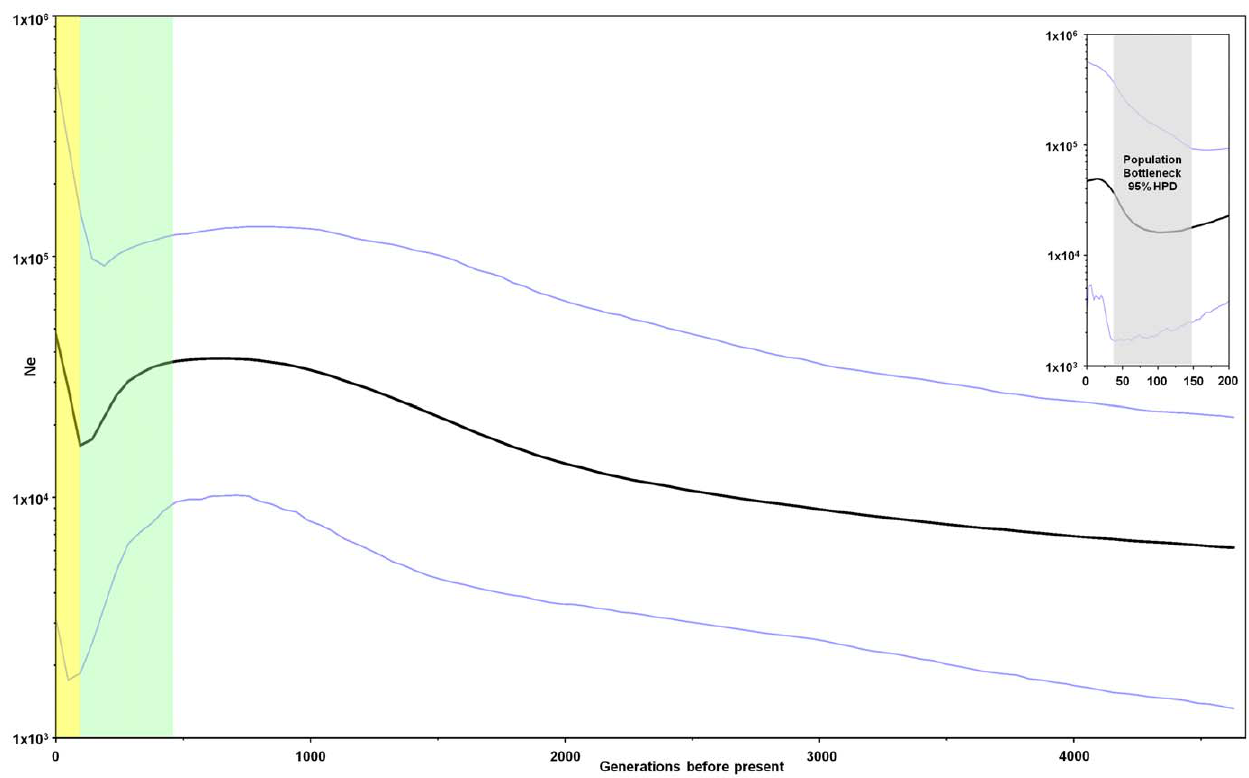
Figure 2. A Bayesian skyline plot derived from a sample of TGM1 haplotypes of contemporary Galicians. The blue lines represent the 95% HPD (highest posterior density) effective population size (Ne) while the black one provides the mean effective population size through time. Green and yellow backgrounds highlight the main periods of population bottleneck and population expansion regarding the mean effective population size, respectively. The upper-right inset shows the last 200 generations; the grey background highlights the bottleneck period that expand to about 30 generations ago according to the lower 95% HDP.